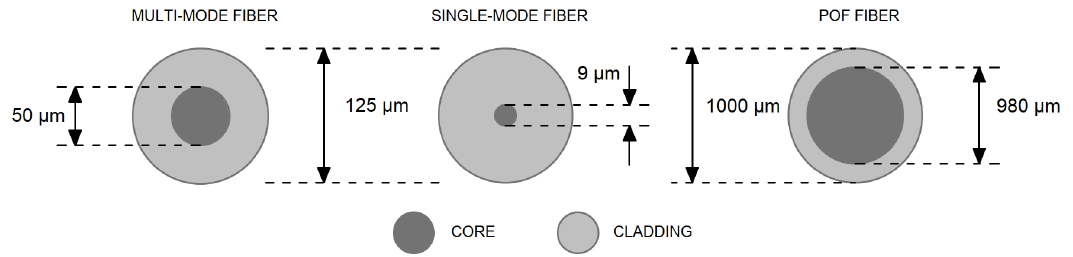
Figure 4. Comparison of glass and plastic fiber.